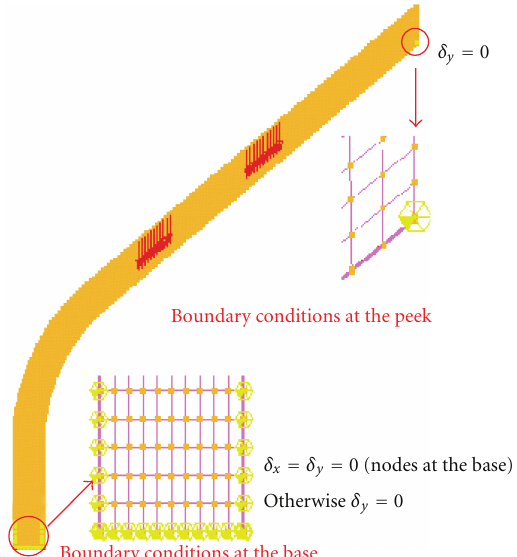
Figure 6: Glulam curved beam finite element boundary conditions.